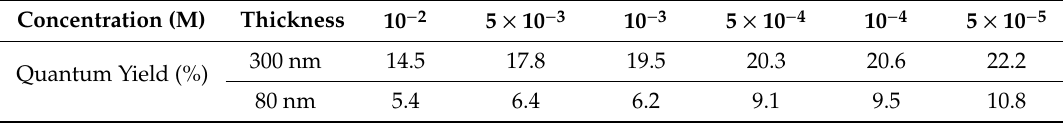
Table 1. The photoluminescence (PL) quantum yields (QYs) of the thin reference films measured using integrating sphere for varied concentrations of rhodamine 6G (R6G) and two di ff erent thicknesses. Concentration (M)